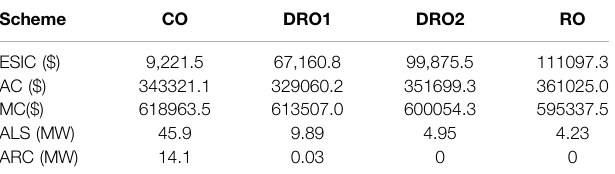
TABLE 2 | Comparison on out-of-sample result of different schemes.